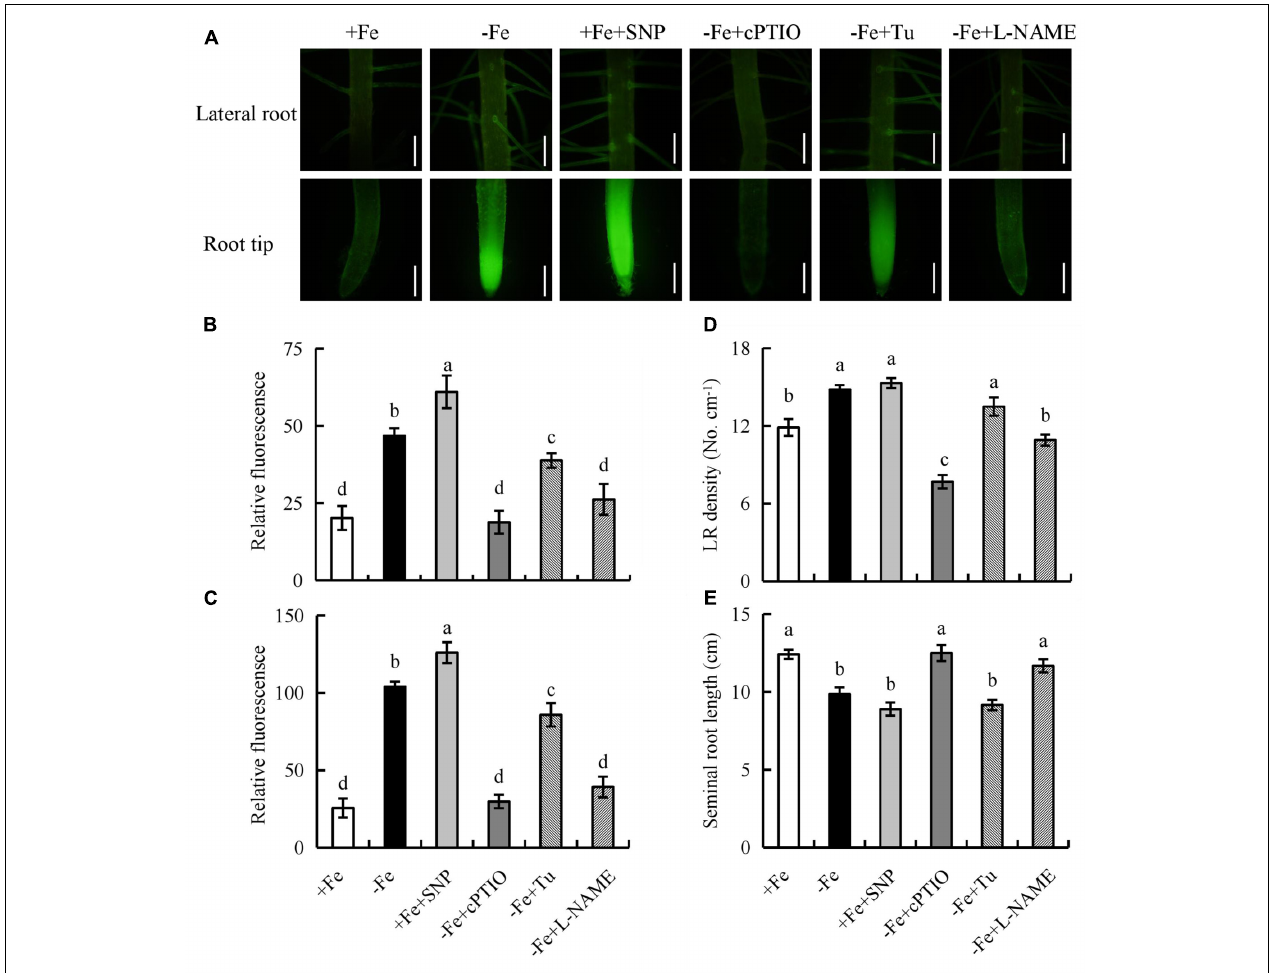
FIGURE 7 | Accumulation of NO and root morphology in the rice seedlings. Seedlings were grown in hydroponic medium containing − Fe (0 µ M) and +Fe (20 µ M) in addition to SNP (30 µ M), cPTIO (80 µ M), Tungstate (Tu; 25 µ M) and L-NAME (100 µ M) for 14 days. (A–C) Photographs of NO production shown as green fluorescence in the seminal root (A) , and NO production expressed as fluorescence intensity relative to LR (B) and RT (C) . (D) LR density. (E) Seminal root length. Bar=1 mm. Data are means ± SE and bars with different letters indicate significant difference at P < 0.05 tested with